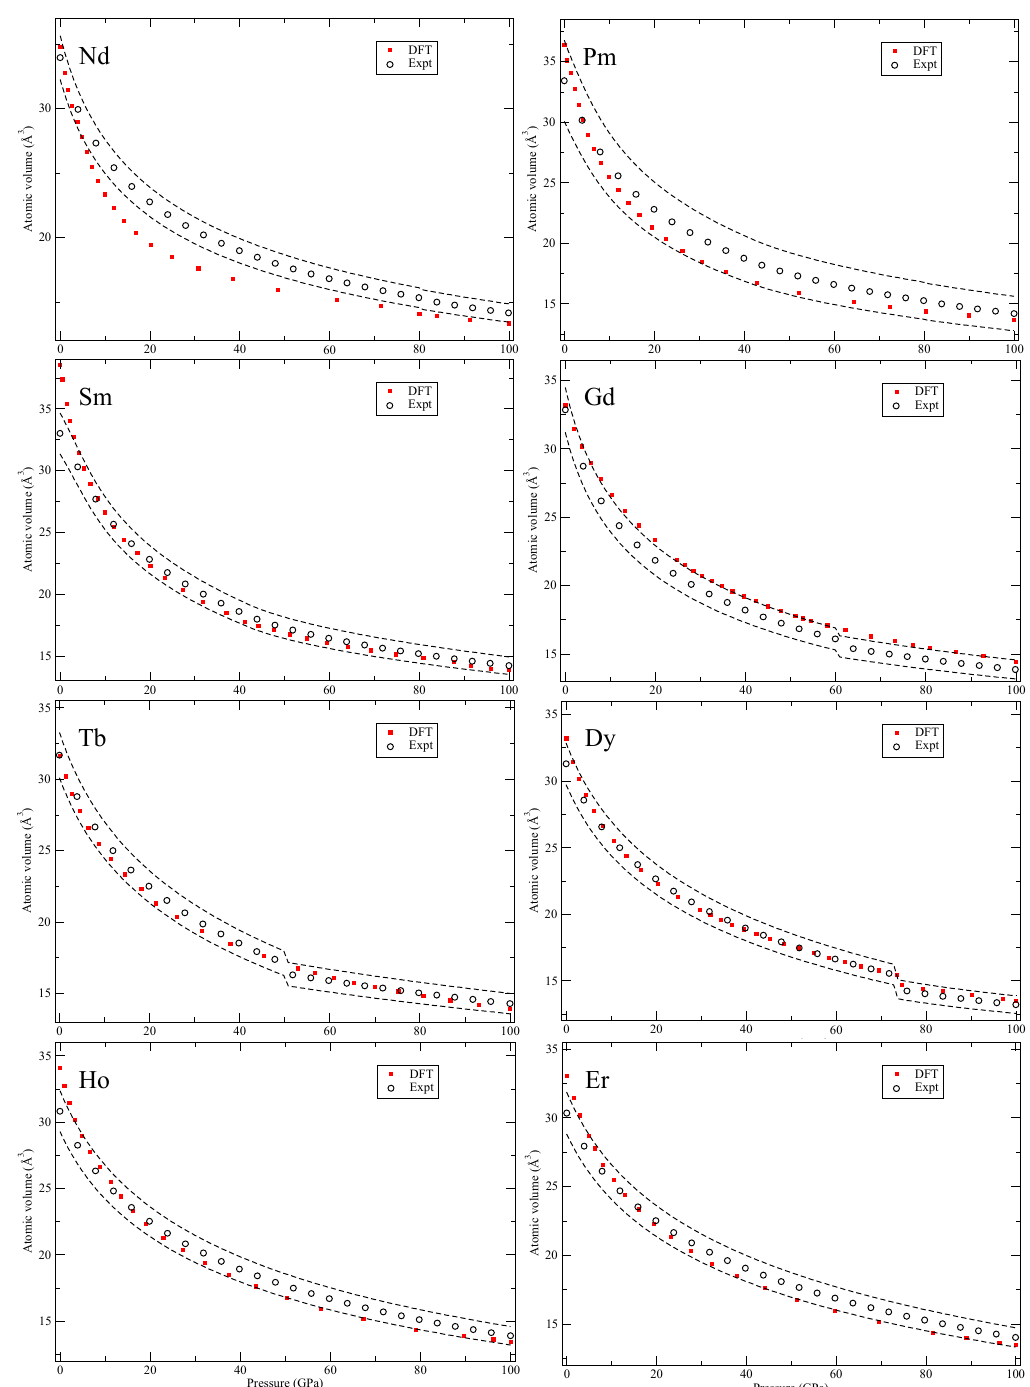
Figure 7. Experimental and DFT EOS for Nd, Pm, Sm, Gd, Tb, Dy, Ho and Er.